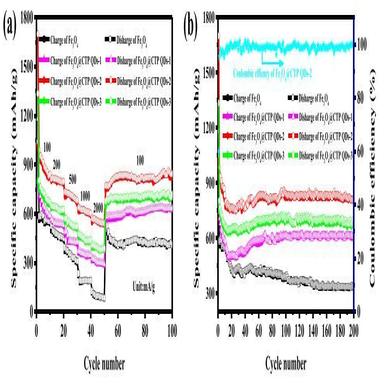
(a) Rate performance of pure Fe3O4 and Fe3O4@CTP QDs composite electrodes at various current densities; (b) Cycle performance of pure Fe3O4 and Fe3O4@CTP QDs composite electrodes and Coulombic efficiency of Fe3O4@CTP QDs-2 electrode.